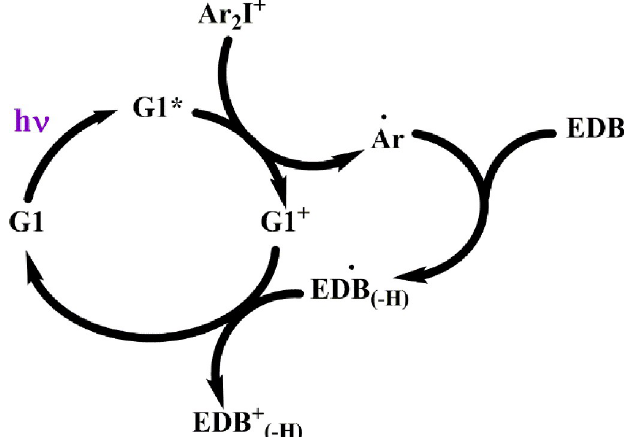
Scheme 3 . Photoredox catalytic cycle for the three-component system